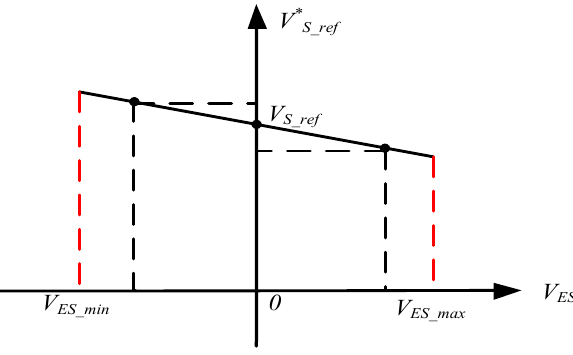
Figure 9. Droop curve of the ES reference voltage [27].